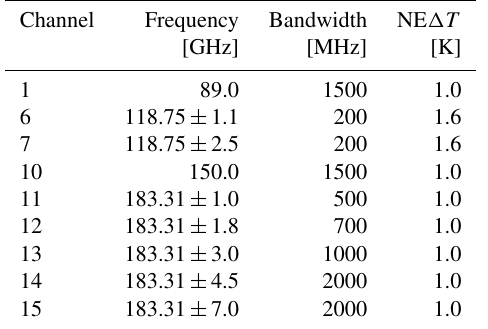
Table 1. Specifications of MWHS-2 channels relevant to this study. Channel